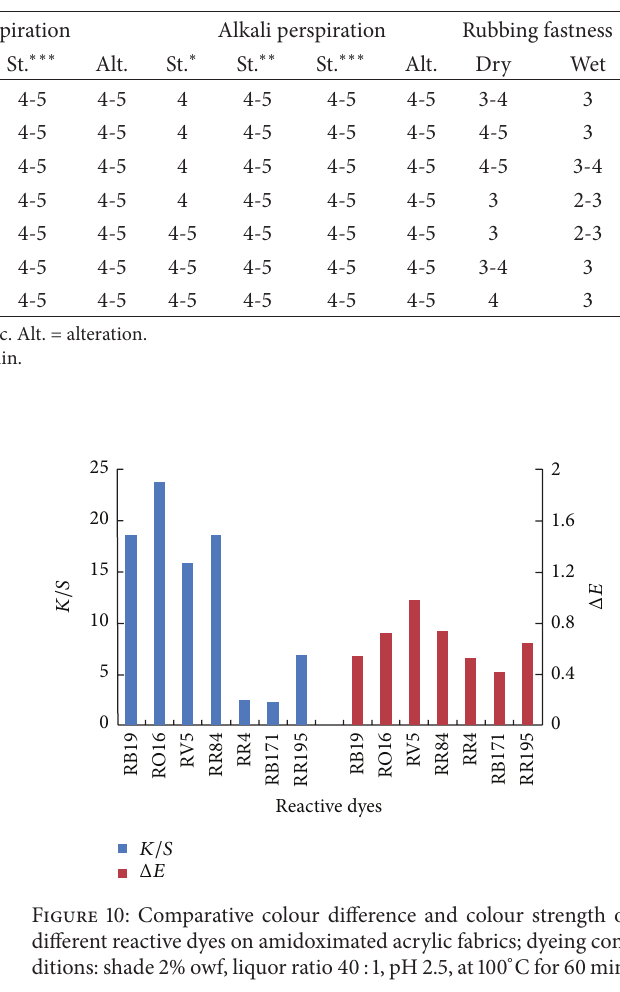
Table 5: Fastness properties of dyed modified acrylic fabrics.